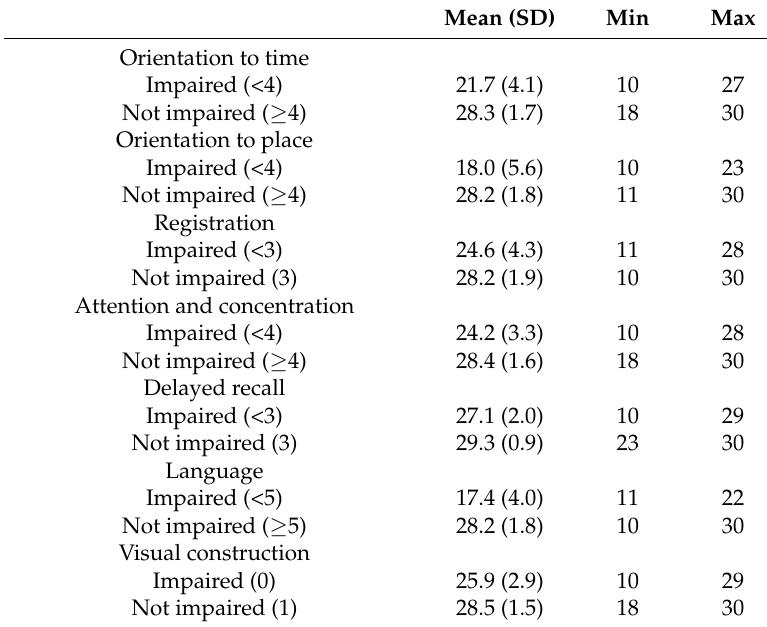
Table 3. Overall MMSE score by MMSE domain impairment